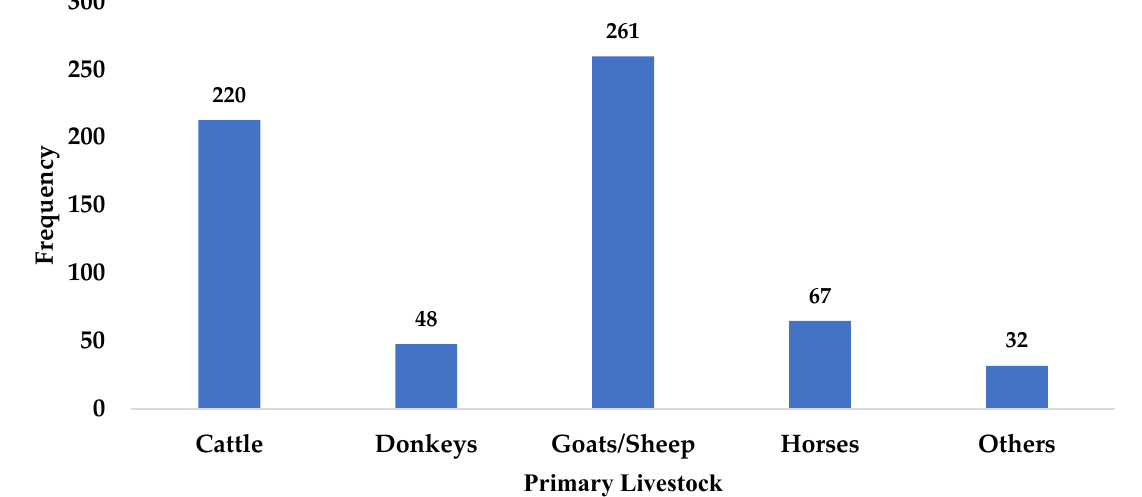
Figure 5. Primary livestock raised by respondents ( n = 300).